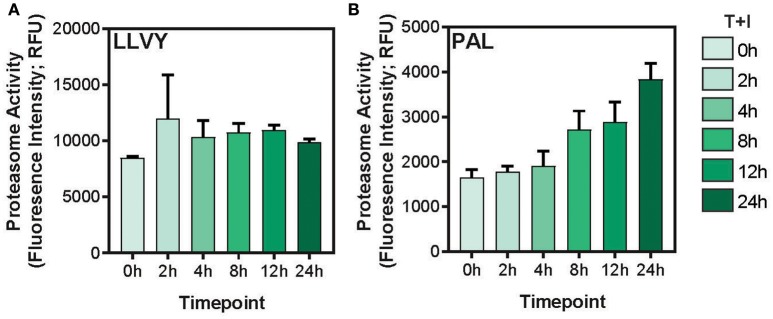
Immunoproteasome activity is induced by TNFα and IFNγ stimulation. (A) The Suc-LLVY-AMC constitutive proteasome substrate or (B) the Ac-PAL-AMC immunoproteasome substrate were incubated with lysates after treatment with TNFα and IFNγ for the indicated times (0–24 h). The final fluorescence measurement in relative fluorescence units (Fluorescence Intensity; RFU) following 3.5 h of incubation with the substrate is plotted (error bars indicate standard deviation).